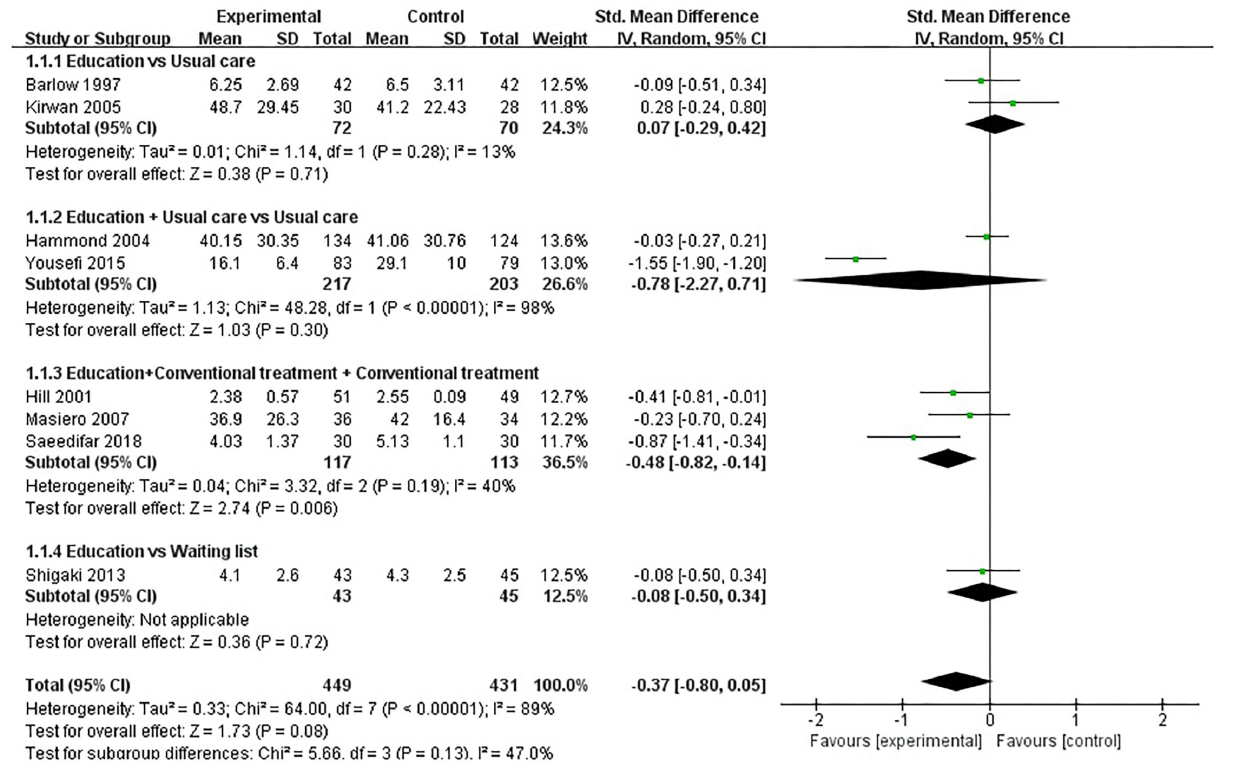
FIGURE 3 | Meta-analysis on